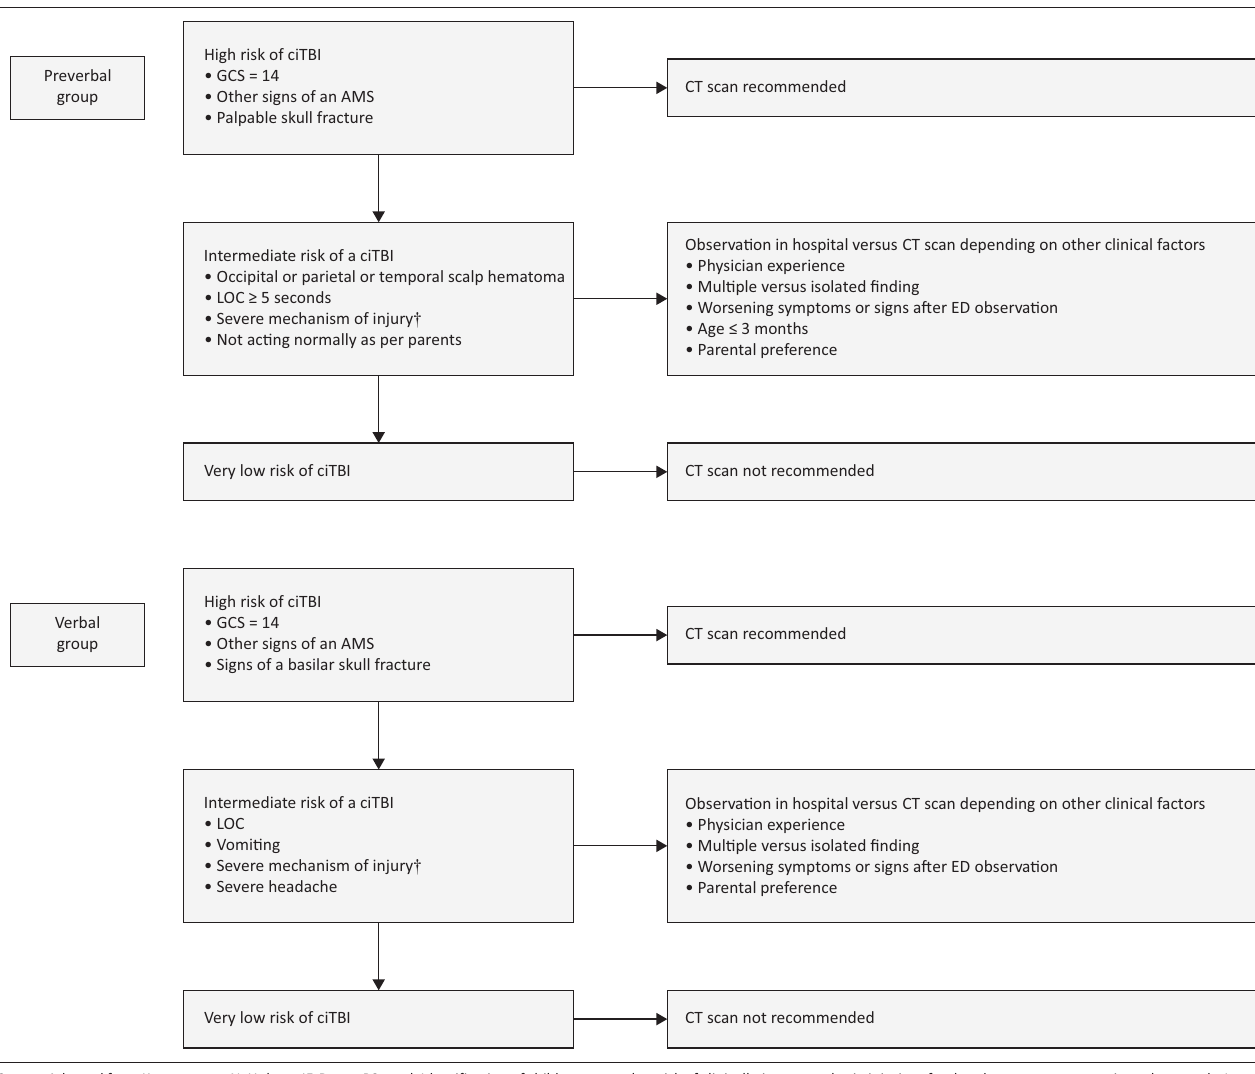
FIGURE 1: Paediatric Emergency Care Applied Research Network clinical decision rule for preverbal and verbal